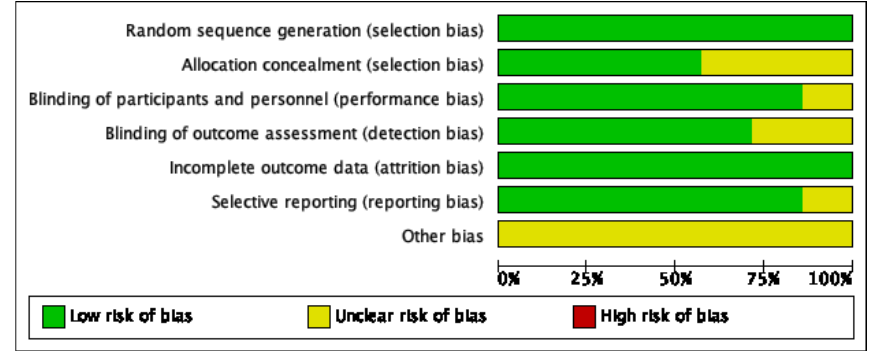
Figure 2. Risk of bias graph: review authors’ judgments about each risk of bias item presented as percentages across all of the included studies.